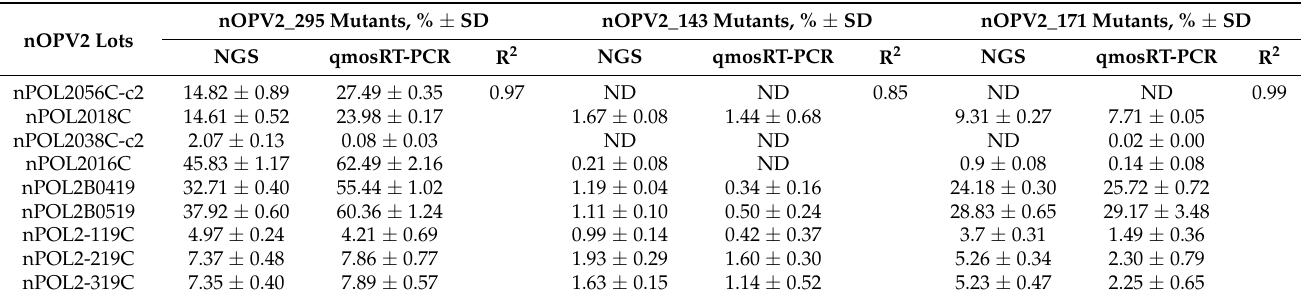
Table 6. Quantification of nOPV2 mutants in nOPV2 batches by qmosRT-PCR assay using plasmids as reference